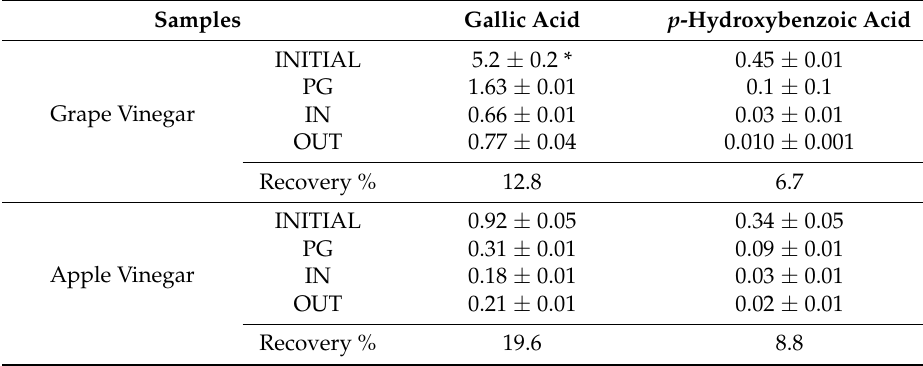
Table 5. The phenolic acid profiles of the in vitro digested grape and apple vinegars.